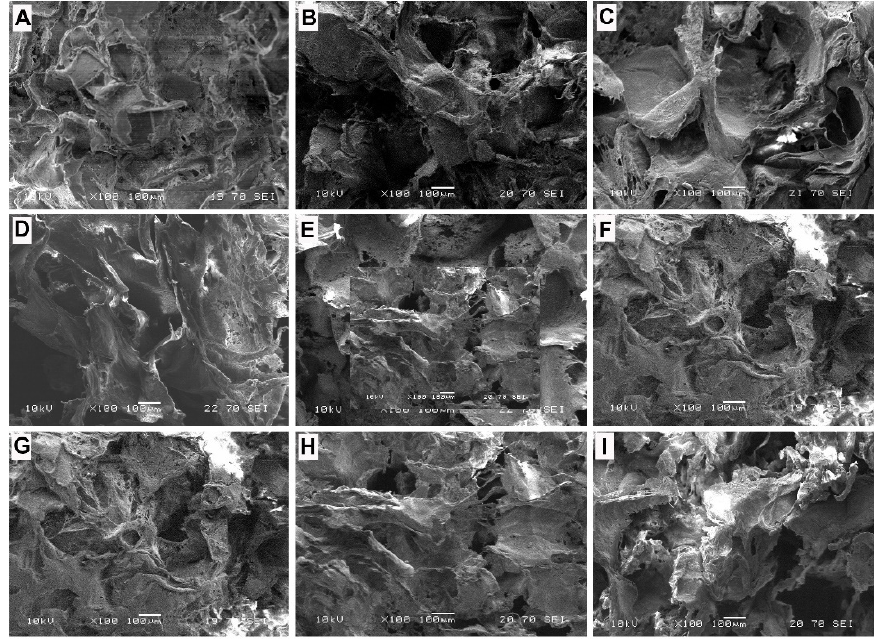
Figure 1. SEM images of the prepared samples: ( A – E ), scaffolds with micron-sized Fe 3 O 4 particles ( μ m-1 to μ m-5, sequentially); and ( F – I ), scaffolds with nanometer-sized Fe 3 O 4 particles (nm-1 to nm-4).